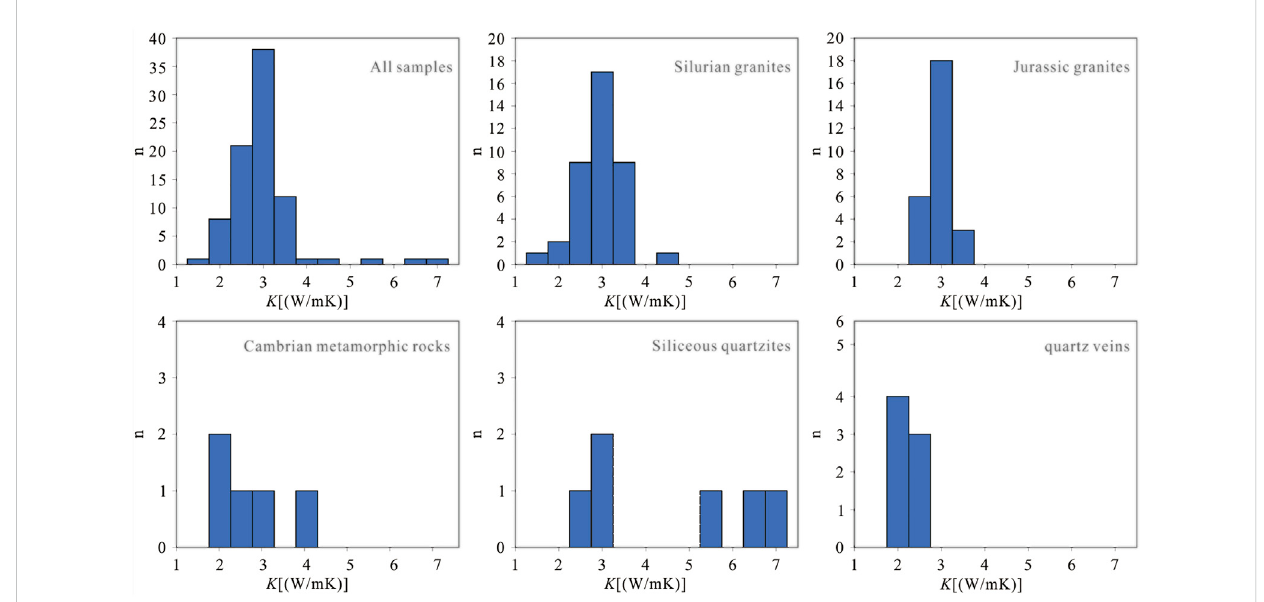
FIGURE 5 Superposition diagram of the geothermal geological map with thermal conductivity